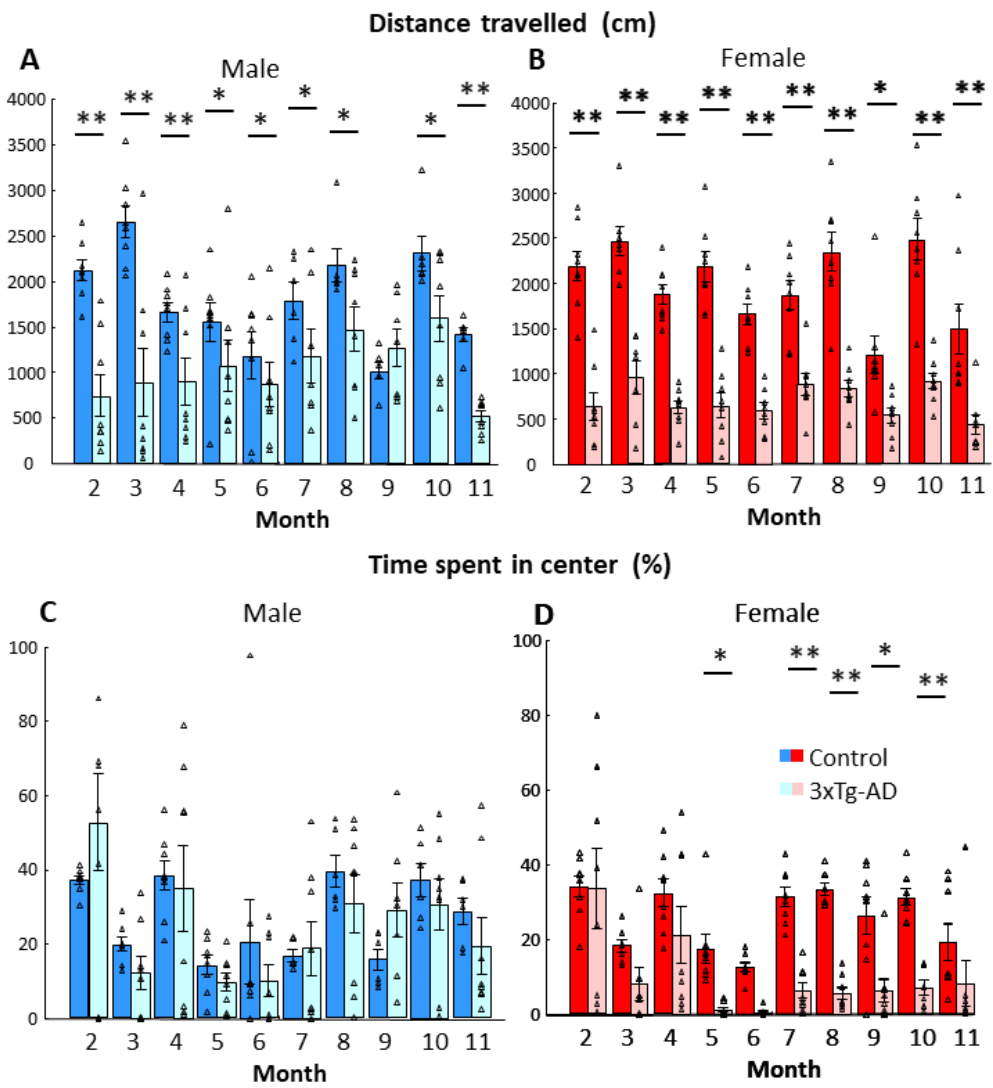
Figure 4. Open-field behavior during monthly testing between 2- and 11-month. ( A , B ) Distance traveled in centimeters during 5 min observation period. There was no overall difference between sexes, however the 3xTg-AD mice moved significantly less than age-matched controls ( p < 0.01). ( C , D ) Percent of time spent in the center of the open field during 5 min observation. The 3xTg-AD animals spent less time in the center of the open field than the control group ( p = 0.026). Data are shown as the mean ± SEM. The individual raw data points are represented as triangles. * p < 0.05, ** p < 0.01 vs. Control. The blues represent male (normal blue: control group, pale blue: intervention group), and the reds represent females ( normal red: control, pale red: